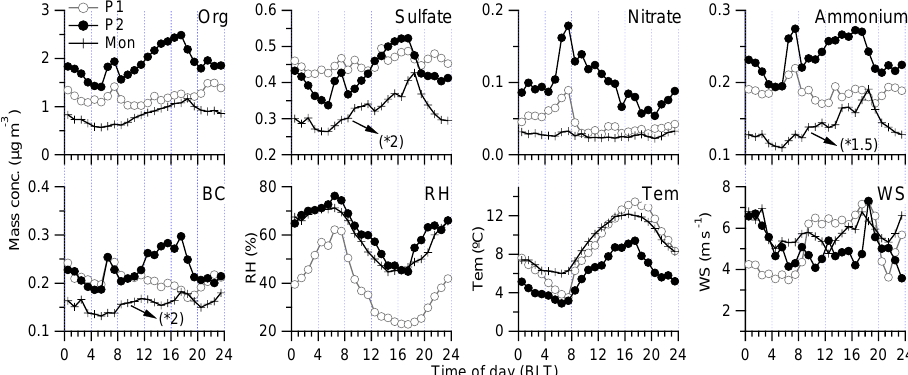
Figure 5. Diurnal variations of each species and weather conditions (RH: relative humidity; Tem: air temperature; and WS: wind speed) during three periods of the study. Note that the signals of sulfate, ammonium, and BC are increased by a factor of 2 or 1.5 for comparison, respectively.